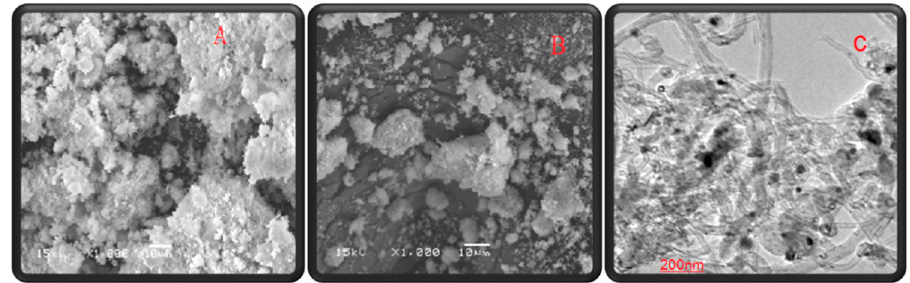
Figure 6. SEM images of Co–Ni/(Al 2 O 3 –ZrO 2 ) catalyst. ( A ) fresh catalyst, ( B ) spent catalyst calcined at 800 °C and operated at 700 °C reaction for 5 h and ( C ) TEM of Co/(Al 2 O 3 –ZrO 2 ) catalyst calcined at 800 °C after recovery from long term POM test (24 h) at 800